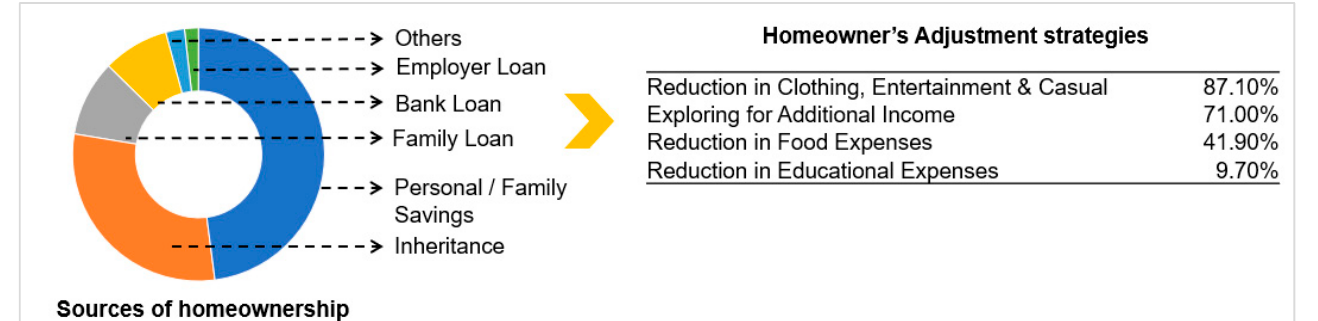
Figure 3. Source of homeownership and adjustment strategies in Dhaka City. Source: [8].